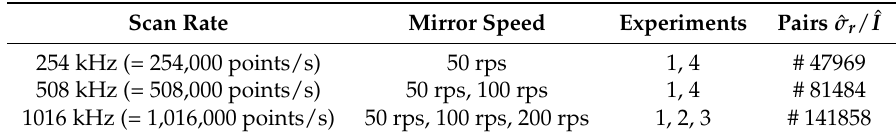
Table 3. Data basis for the determination of intensity-based stochastic models for all three scan rates of the Z + F Profiler 9012A (i.e., 254 kHz, 508 kHz and 1016 kHz). Scan Rate Mirror Speed Experiments Pairs ˆ σ r / ˆ I 254 kHz (= 254,000 points/s) 50 rps 1, 4 # 47969 508 kHz (= 508,000 points/s) 50 rps, 100 rps # 81484 1016 kHz (= 1,016,000 points/s) 50 rps, 100 rps, 200 rps 1, 2, 3 # 141858